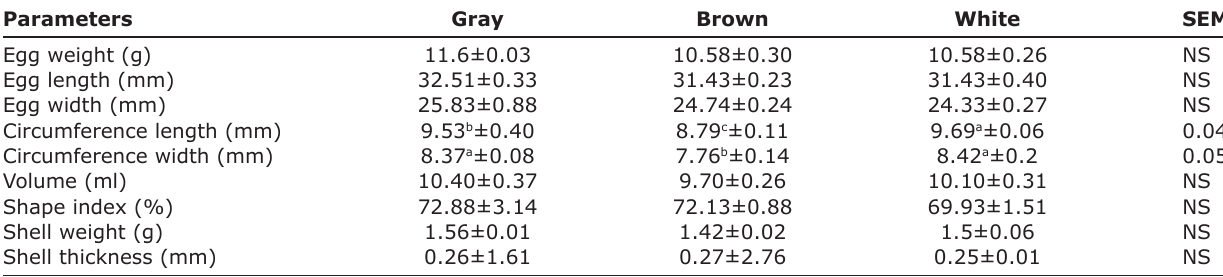
Table-3: External egg quality traits of three varieties of Japanese quail. Parameters Gray